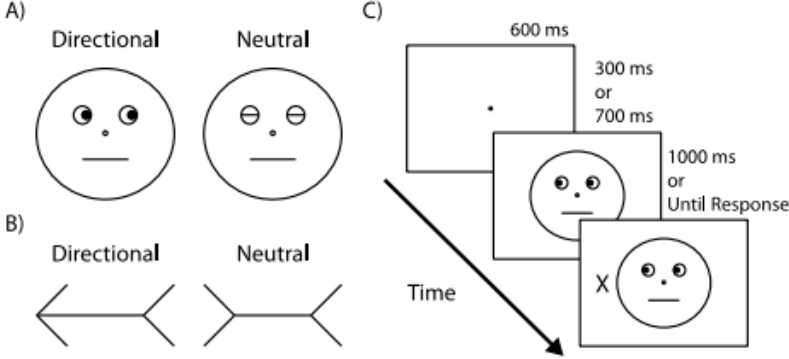
Figure 12. Example of cues and of a valid trial employed by Blair et al. [44].